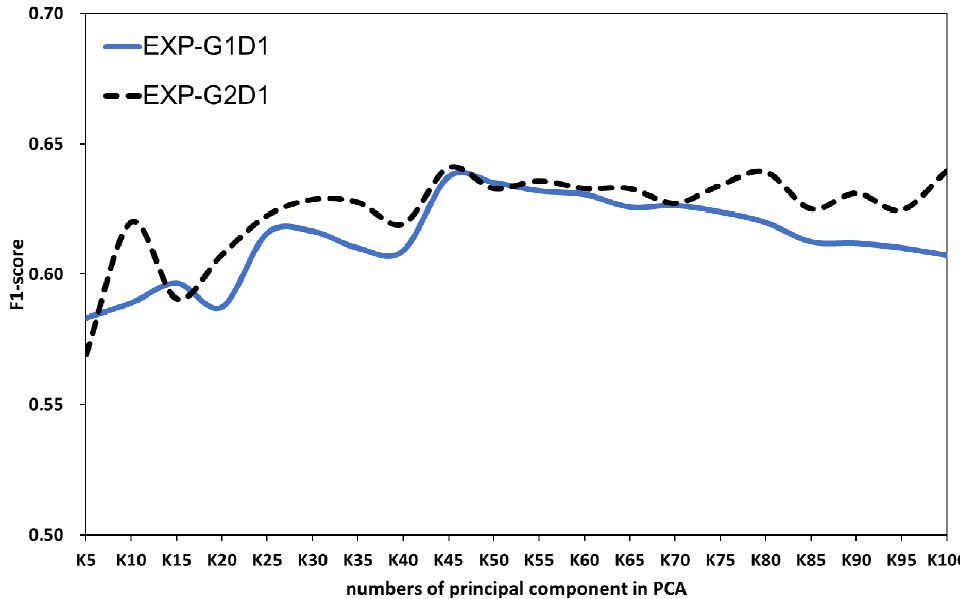
Figure 3. The F1-scores of EXP-G1D1 and EXP-G2D1 along with the numbers of PCs. Domain selection may be another factor to influence the performance of schemes.